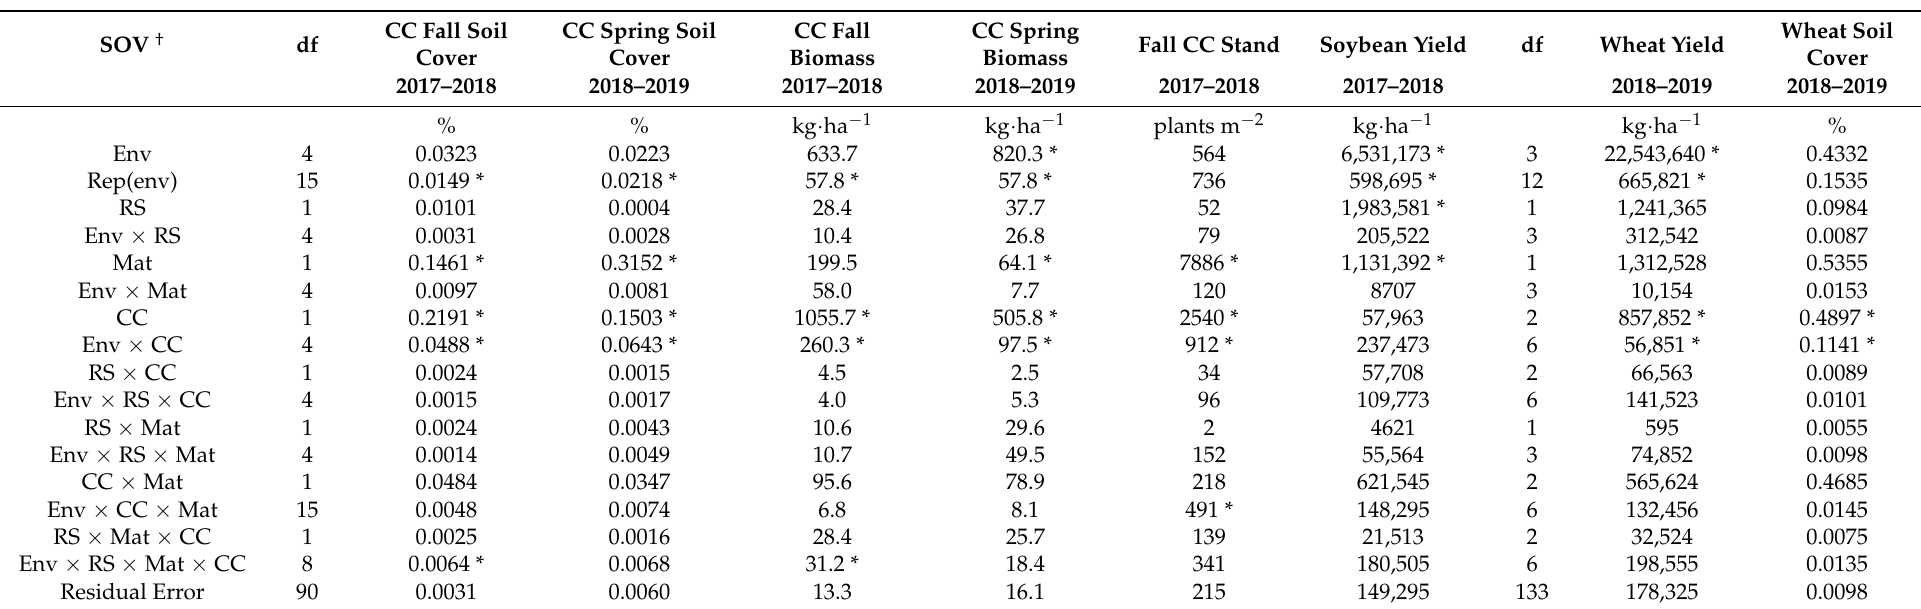
Table 8. Mean square values for row spacing (RS), maturity (Mat), cover crop (CC), and five environments (Env) at Fargo, ND, 2017,